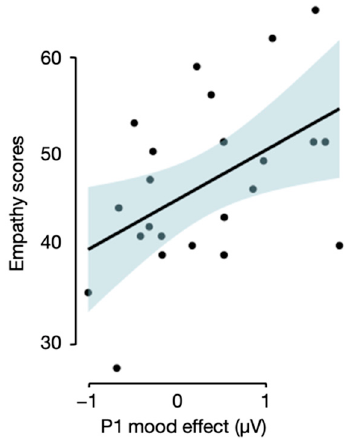
Figure 3. A correlation plot depicting the relationship between the P1 mood effect and participants’ empathy level.